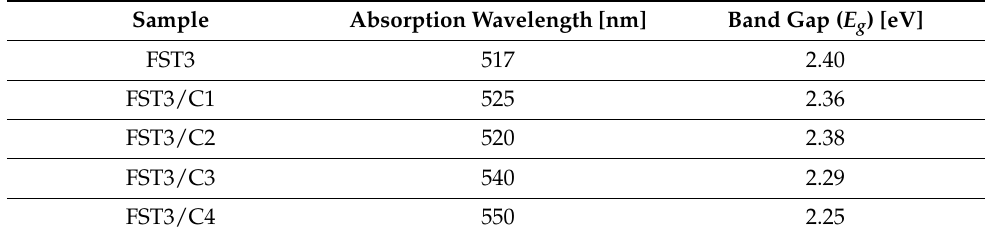
Table 1. Estimated absorption wavelengths and calculated band gaps for different MWCNT loadings.